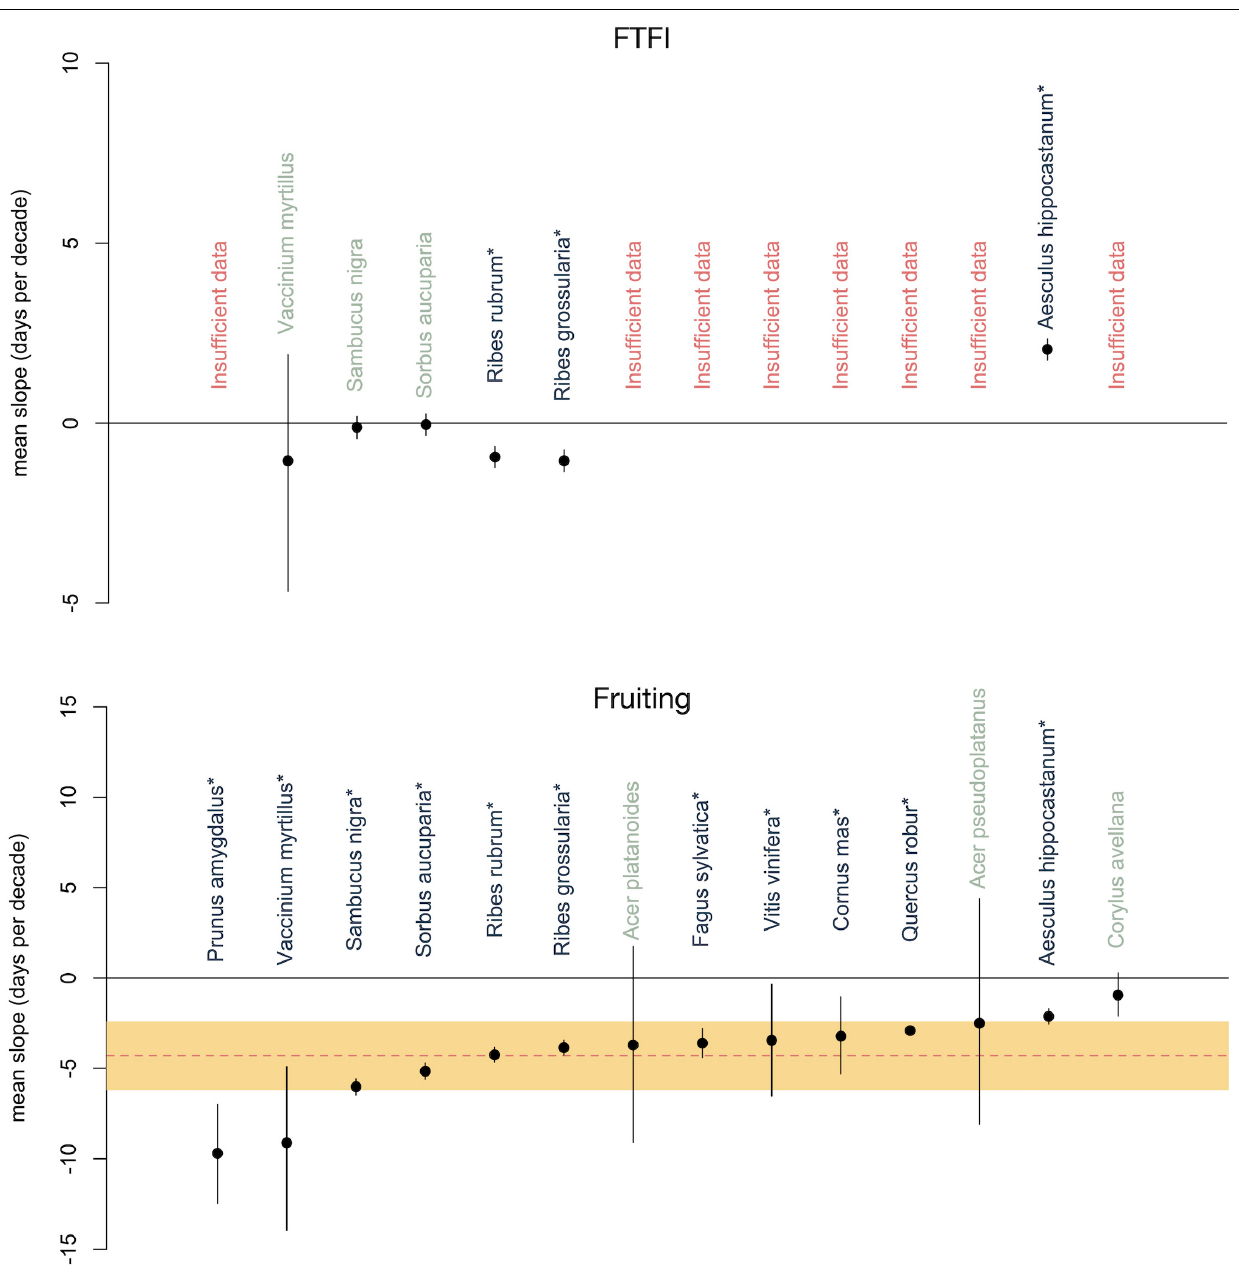
for the same species from 1951 to 2018 (Menzel et al.,